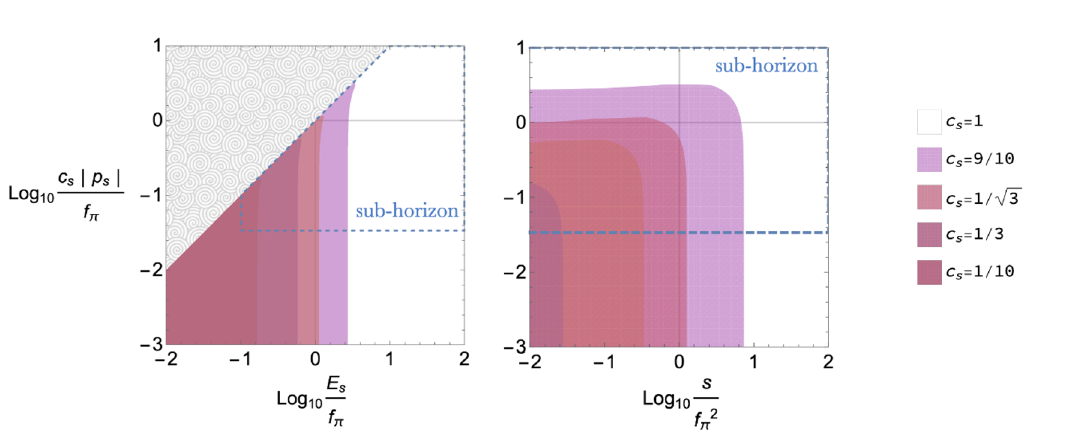
Figure 5. Bounds on the perturbative unitary regions of the scaling superfluid for spherical wave coefficient up to ‘ = 2 . Each colored region corresponds a different value of c s with the conformal √ superfluid corresponding to c s = 1 / 3 . All colored regions extend to arbitrarily low | p s | , E s and s , as spherical wave coefficients get smaller. The dashed enclosed region represents the subhorizon regime of scattering. Left: weakly-coupled regions for various scattering energies E s and momenta | p s | . The patterned region is forbidden kinematically. Right: same weakly-coupled regions, this time in terms of the Mandelstam variable s and momentum | p s | . For a given c s , the maximum s = s max is reached at low | p s | while | p s | max is reached at an intermediate s